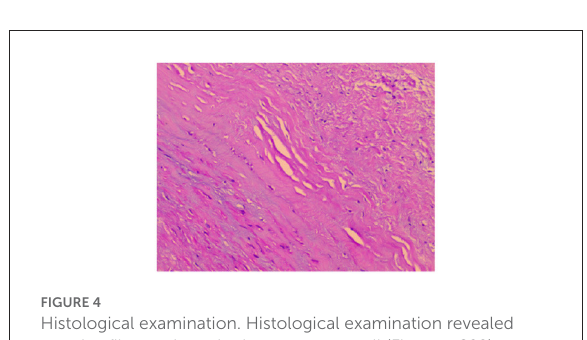
FIGURE4 Histological examination. Histological examination revealed massive fibrous tissue in the aneurysm wall (Figure ×